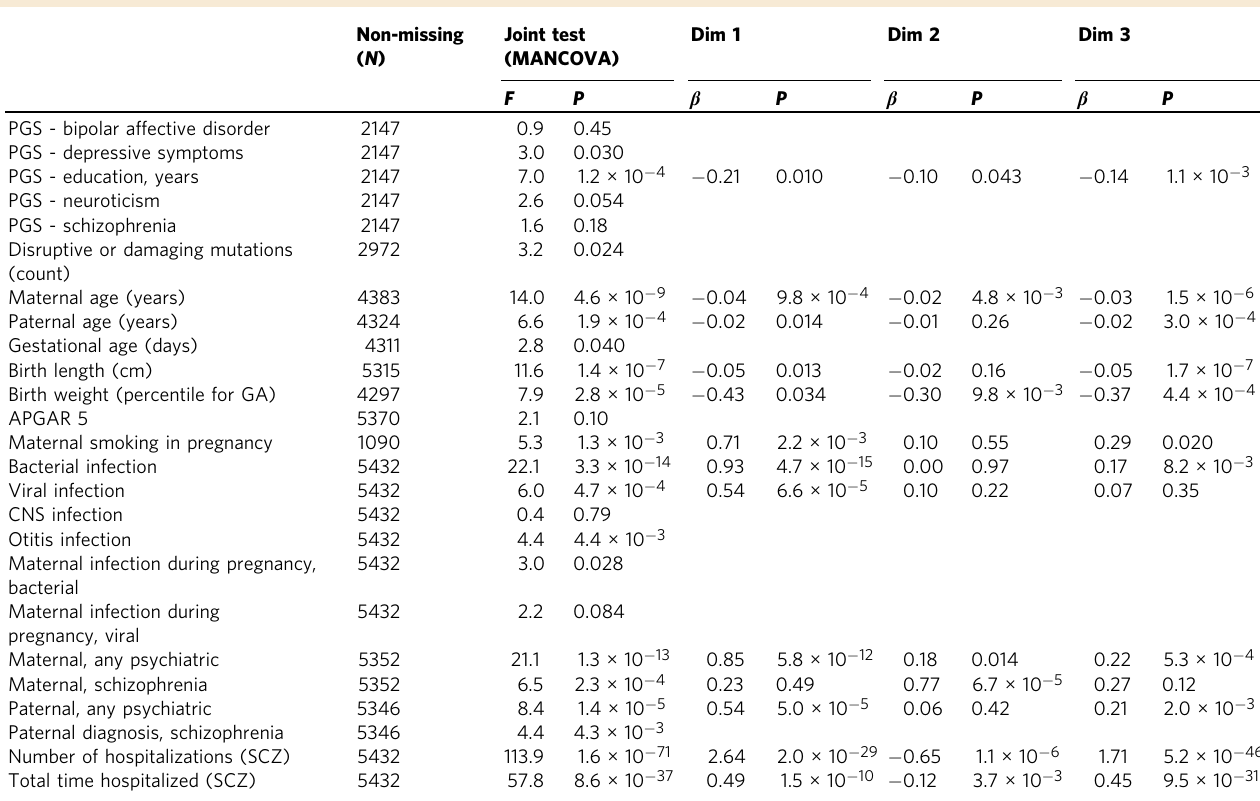
Table 2 Results of the test for association between the principal dimensions of the comorbidity trajectories and schizophrenia risk factors and outcomes within the 5432 individuals with